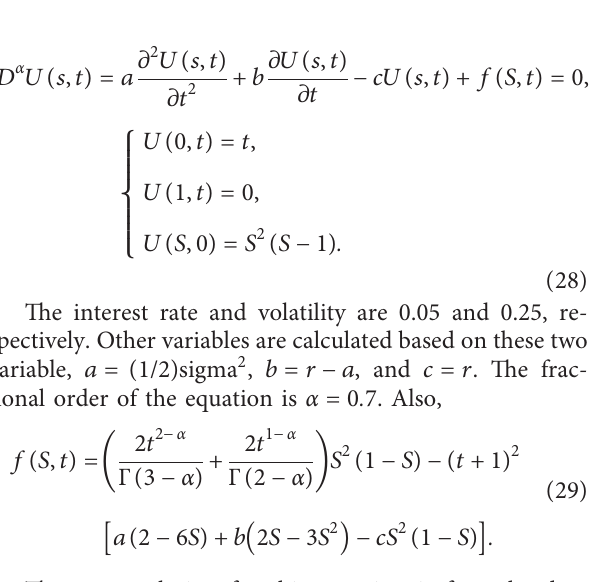
Figure 2: Plots of the approximated solutions of Example 1 when the number of hidden neurons is 20 and d t � 1/20. (a) U ( S, 0 ) . (b) U ( S,t ) , t ∈ [ 0 ,T ]